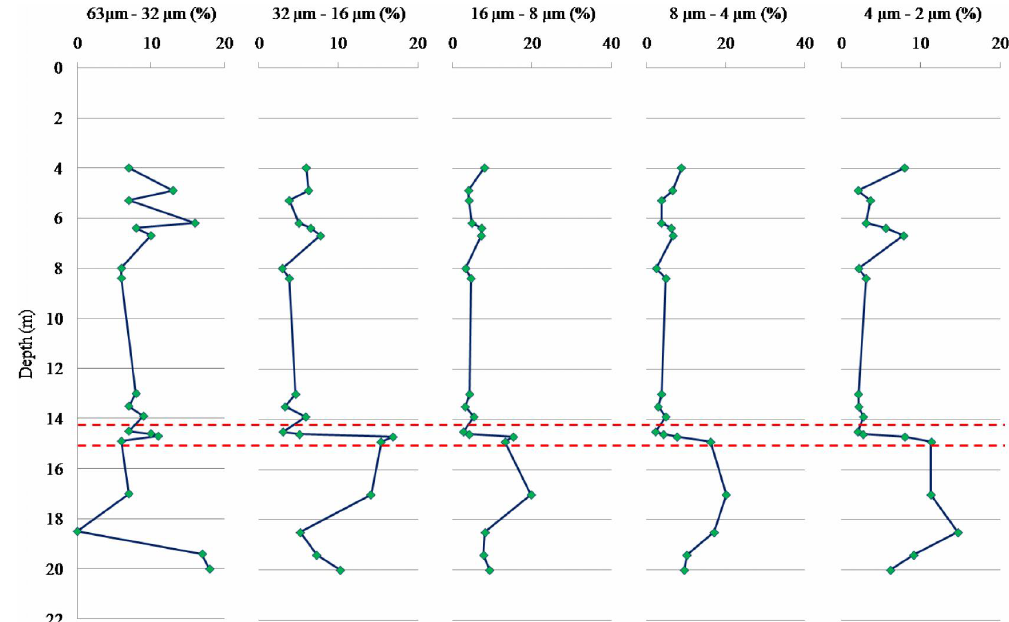
Figure 6. Trend of silt fraction variation with